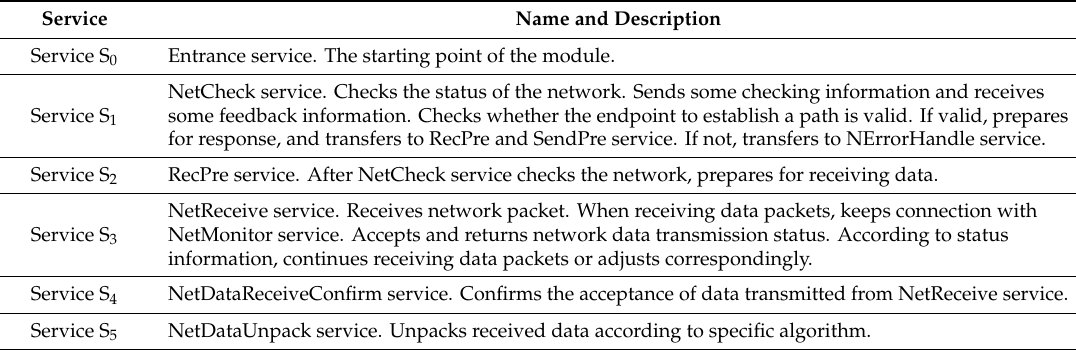
Table A2. Name and description of each service in network reception and dispatch